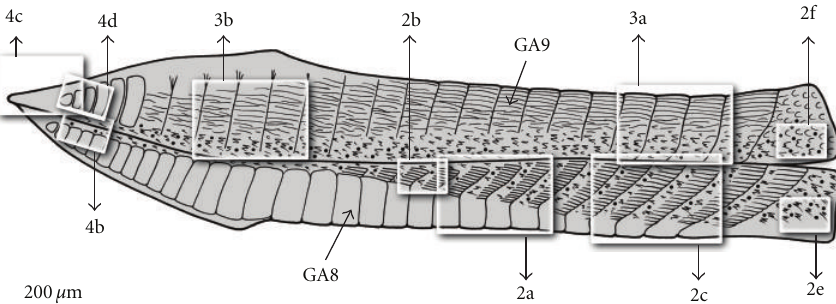
Figure 1: General organization of microsculpture on the inner surface of the ovipositor in the silverfish, Tricholepidion gertschi , diagram- matically. Rectangles indicate relative locations of the SEM micrographs given in the next figures (except Figures 2(d), 3(c), 3(d), and 4(a)). Black dots indicate the ovipositor parts with dome-shaped sensilla. GA8 and GA9: the gonapophyses of 8th and 9th segments,